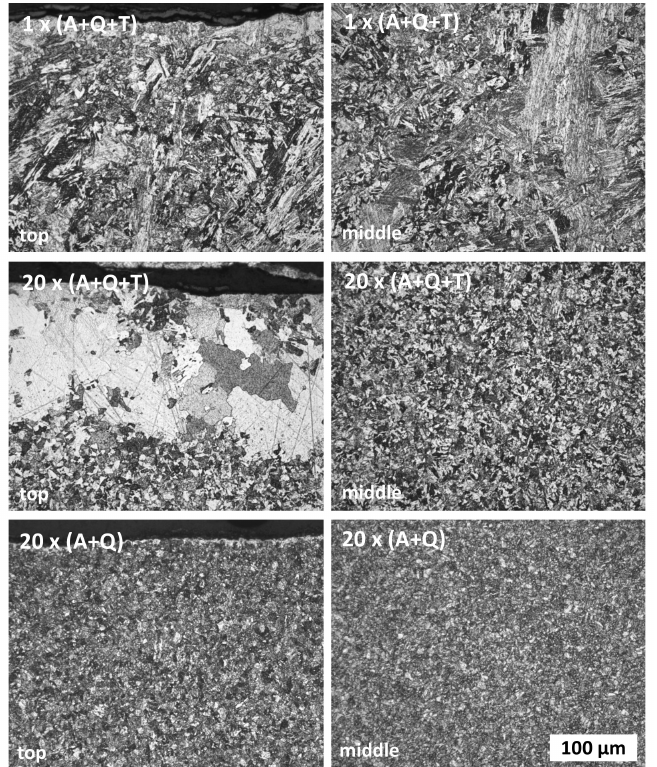
Figure 20. The effect of multiple heat treatments on the microstructure of a 1 10 mm thick EUROFER97/2 plates. The weld pieces were machined from a 25 mm plate, heat 993402. The optical micrographs show cross-sections from the middle part of the 85 mm long weld lines. The micrographs were made from the top and middle parts of the cross-sections (indicated in the images). The heat treatment is indicated as follows: austenitization at 980 ◦ C for 30 min (A), air quenching (Q), and tempering at 750 ◦ C for 2 h